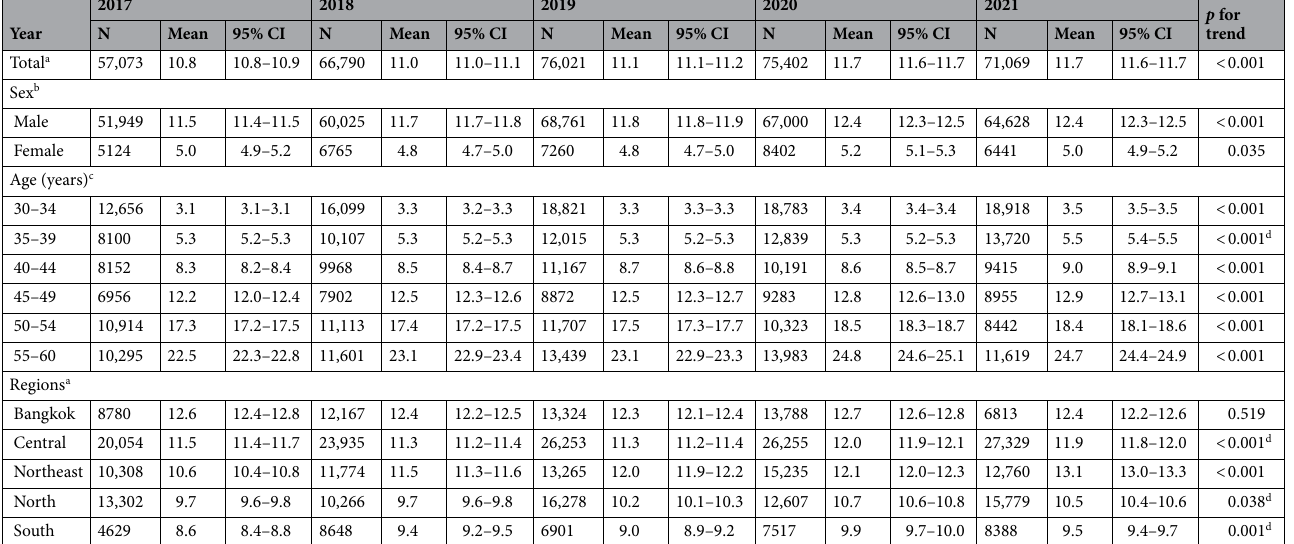
Table 2. Means (%) of predicted 10-year risk for CVD among RTA personnel from 2017 to 2021. a Age- and sex adjusted mean using regression analyses. b Age-adjusted mean using regression analyses. c Sex-adjusted mean using regression analyses. d Nonlinear trend. CVD cardiovascular diseases, RTA Royal Thai Army, 95% CI 95% confidence interval.